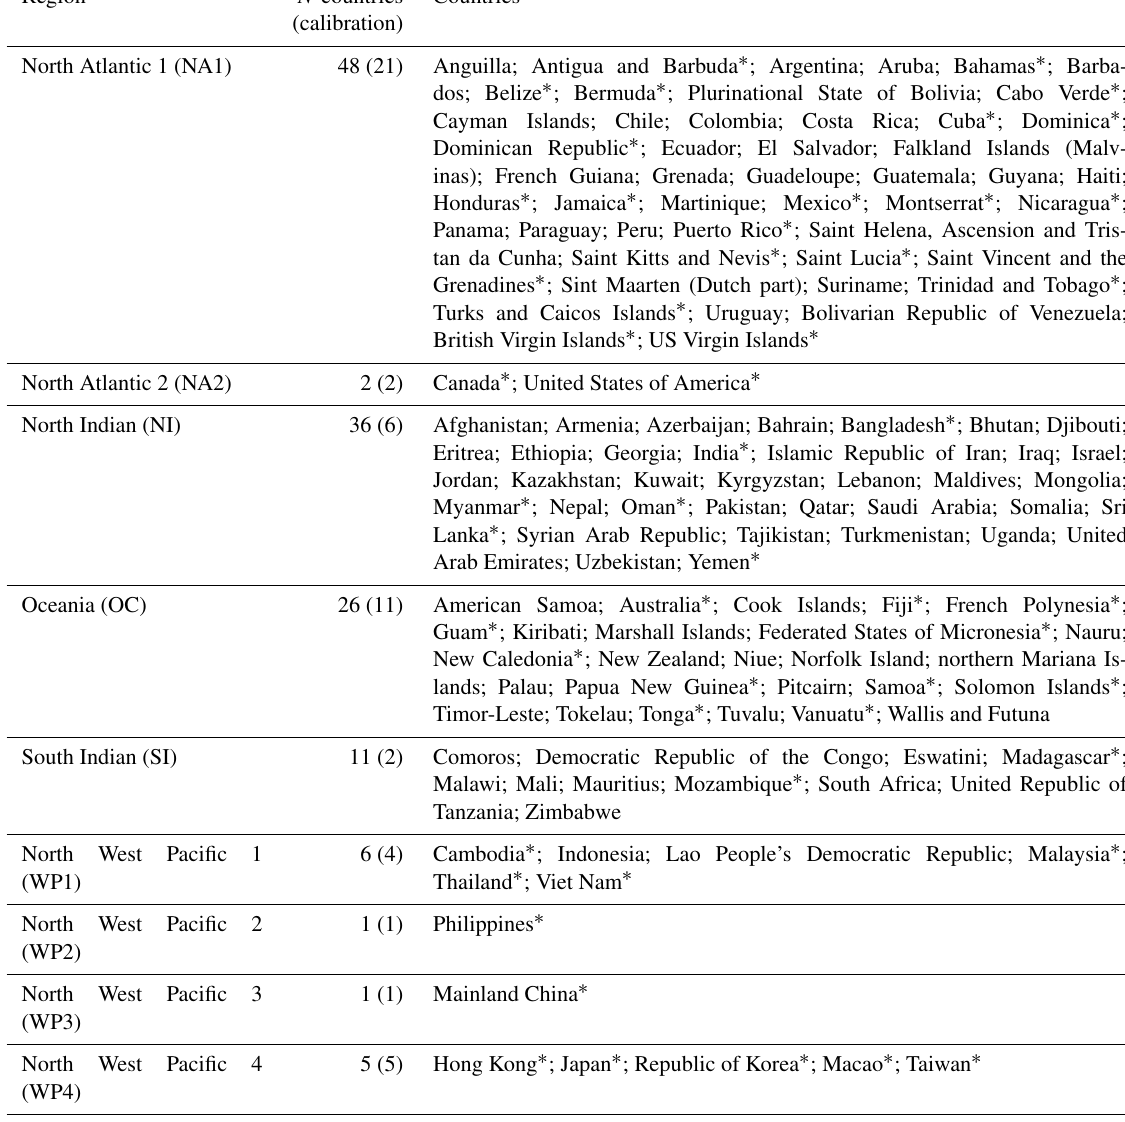
Table A1. List of countries per calibration region. Countries marked with an asterisk ( ∗ ) are considered for calibration (53 in total).